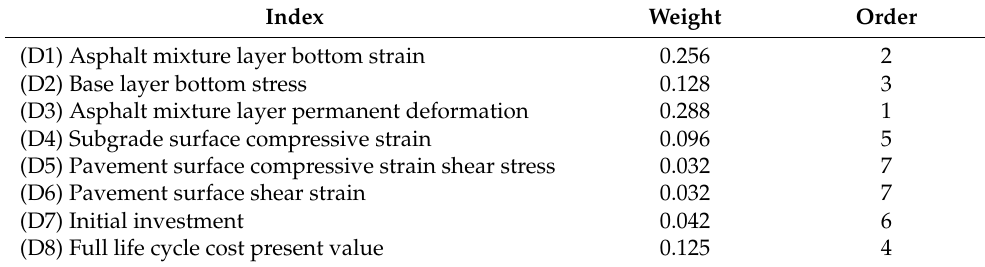
Table 7. Evaluation index weight.